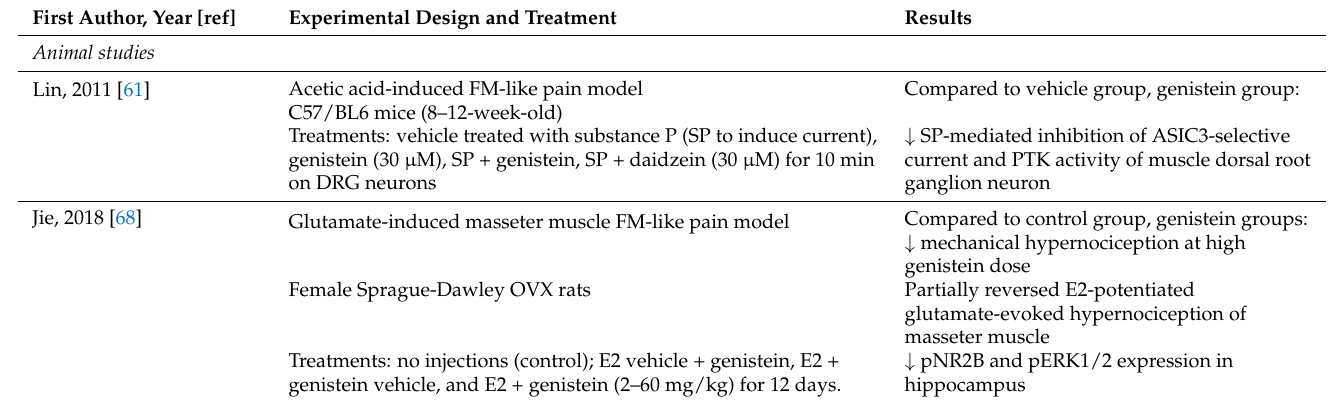
Table 7. Effects of genistein on fibromyalgia-like